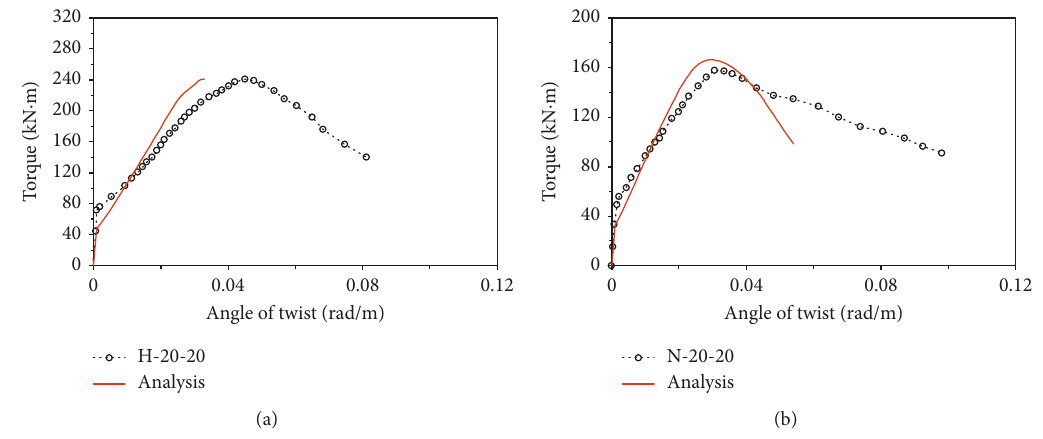
Figure 15: Analysis and test results comparison for beam 4: (a) H-20-20 and (b) N-20-20. Table 2: Ultimate torque and the corresponding angle of twist: test versus sectional analysis results.